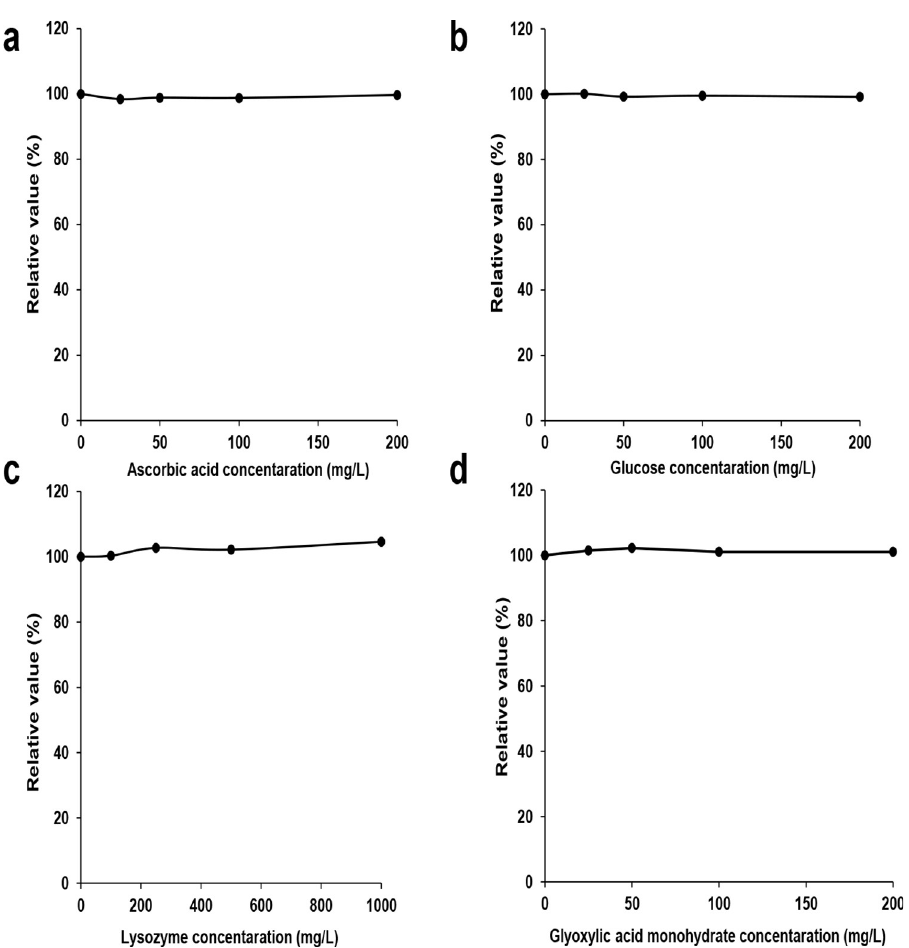
Fig 5. Effects of interference substances on absorbance values of Trp. Change of the absorption intensity (525 nm) of Trp solution (50 mg/L) containing several concentrations of (a) AA, (b) glucose, (c) lysozyme, and (d) glyoxylic acid, after the addition of 400 g/L of MSG, 10% HCl, and 5% NaOCl � 5H 2 O. correlation was confirmed (R 2 = 0.9996) (Fig 6). Based on the data, recovery experiments were performed by spiking different concentrations of Trp standard solution into CSF prior to the pretreatment step. The recovery ratio at two spiked levels was in the range of 90.5% to 104.3% with a relative standard deviation of 0.27% (n = 3, 29.40 mg/L Trp) to 1.19% (n = 3, 72.90 mg/ L Trp), which confirmed that the optimized colorimetric assay can detect Trp in spiked pool specimen with little interference (Table 1). Previous reports showed that blood plasma from healthy subjects contained amounts of Trp between 8.8 and 15.2 mg/L [31], and the urinary Trp levels of patients with Hartnup disease, which is an inborn metabolic disorder involving Trp, contained more than 35 mg/L [32]. Although we did not detect concentrations of Trp less than 10 mg/L, absorbance at 525 nm showed a linear trend from 10 to 100 mg/L (Fig 6). To develop a quantitative method for Trp, further examinations to detect Trp solutions contain- ing less than 10 mg/L are required for the verification of several conditions, including the opti- mal pH and concentrations of MSG and NaOCl � 5H O. However, our current results indicate 2 that the spectrophotometric method may be useful for the detection of Trp in biological samples.